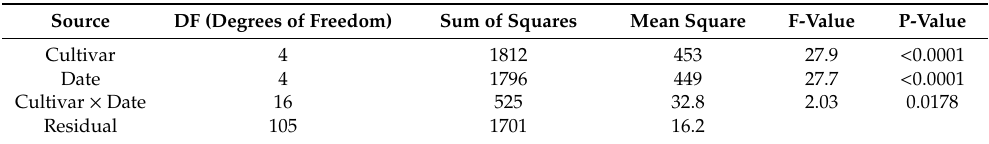
Table 1. Analysis of variance for measurements of water-use e ffi ciency (WUE i ) of five soybean cultivars measured on five dates in 2017.